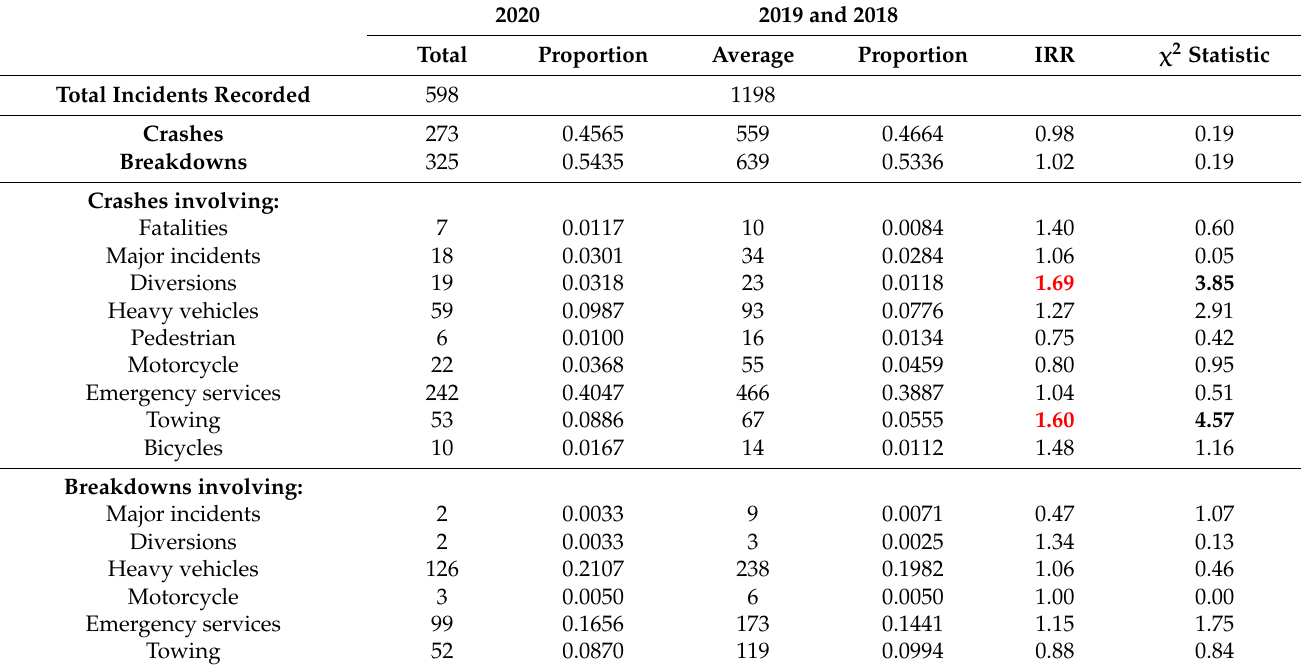
Table 2. Ratio of incident characteristics to the total incidents recorded for the month of April in 2020 (first lockdown), 2019 and